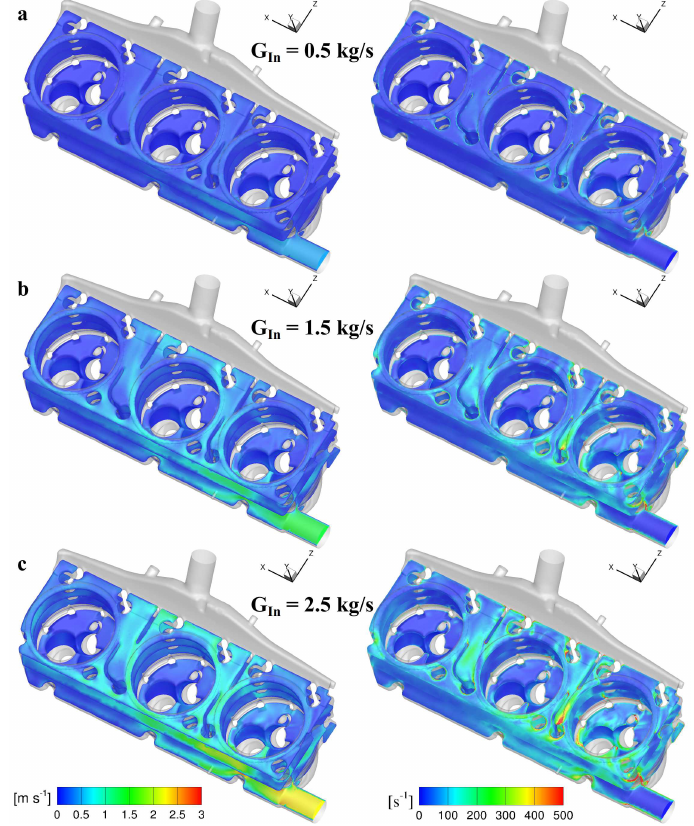
Figure 4. Velocity and vorticity contour plots for the single-inlet geometry. Distribution of velocity (left) and vorticity (right) magnitude for G In = 0.5 ( a ), 1.5 ( b ), and 2.5 ( c )